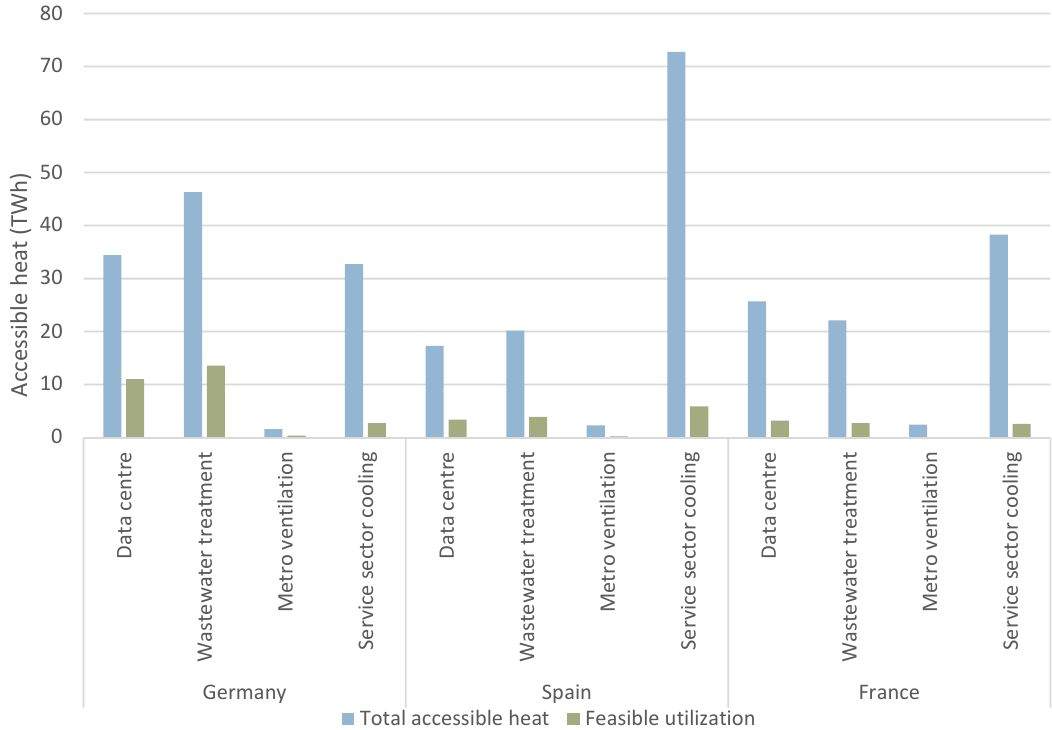
Figure 9. Accessible heat for the di ff erent scenarios, heat sources and countries in 2050.